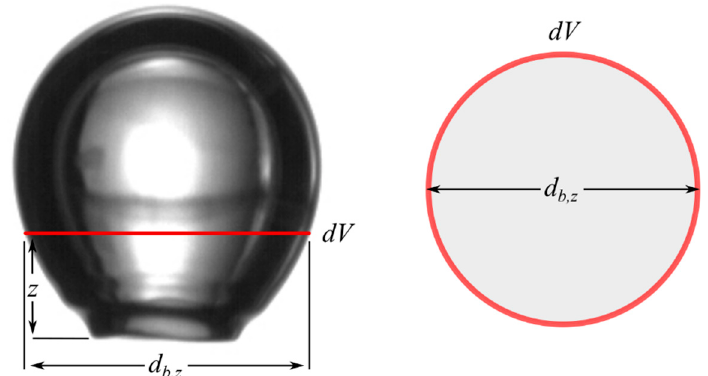
Figure A1 . Schematic of the differential volume element dV in determining the bubble volume. Figure A1. Schematic of the differential volume element dV in determining the bubble